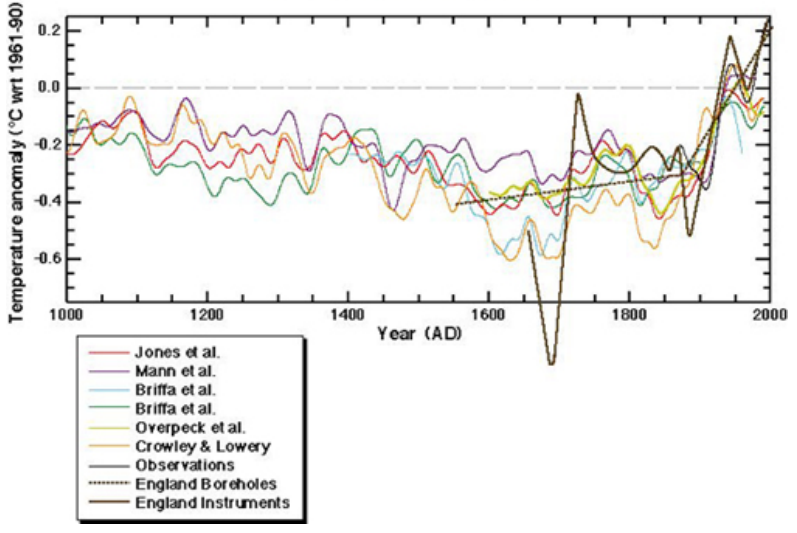
FIGURE 9. Most recent temperature proxy compilations for the NH. Also plotted for comparison are average borehole and instrumental temperatures for central